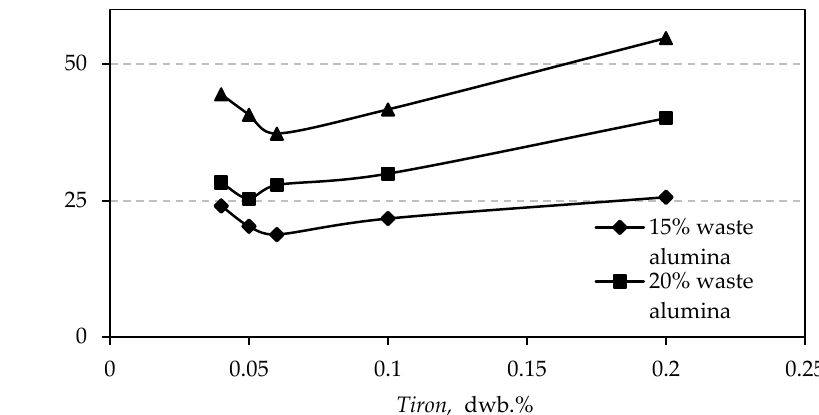
Figure 1. Apparent viscosity of alumina 70 wt.% suspensions with three different amounts of waste alumina powder as a function of Tiron concentration (dwb.%).